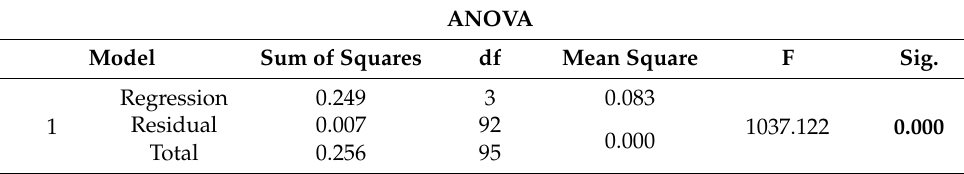
Table 5. Test of the validity of the MLR model.